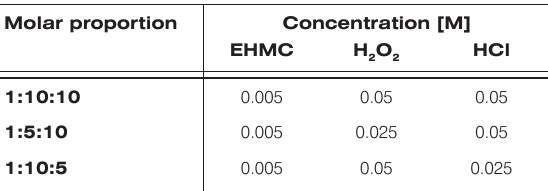
Table 1. Molar proportions and concentrations of the reagents in the studied systems. Molar